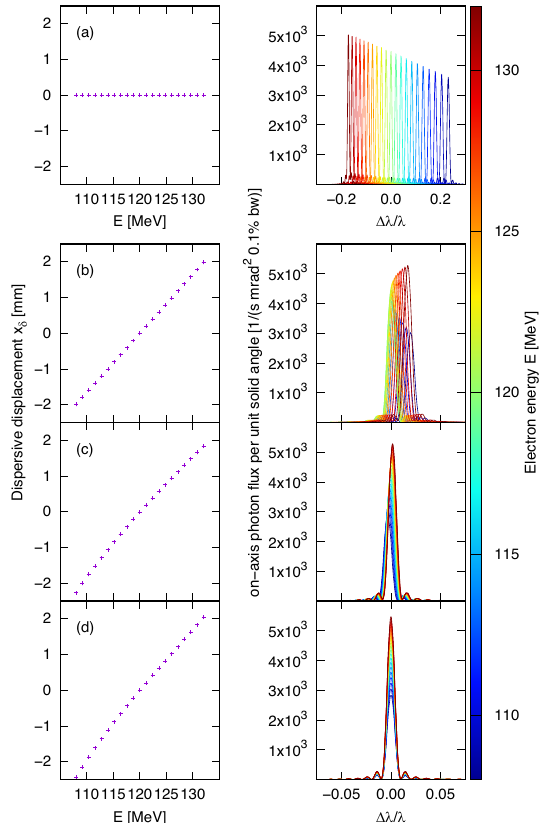
FIG. 5. Basic proof of the TGU concept: Electron energy dispersion and resulting radiation spectra for an electron energy band of Δ E ¼ 120 MeV (cid:2) 10% for the cases (a) planar undulator with K ¼ 1 . 07 , (b) ideal linear TGU with K linear dispersion (Eq. (4) of the original article), (c) the same with nonlinear dispersion according to Eq. (12) of the original article, (d) idealized cylindric SCTGU with optimized dispersion. For all cases a beam current of 10 pA, equally distributed over the 21 monoenergetic zero-emittance beamlets, is